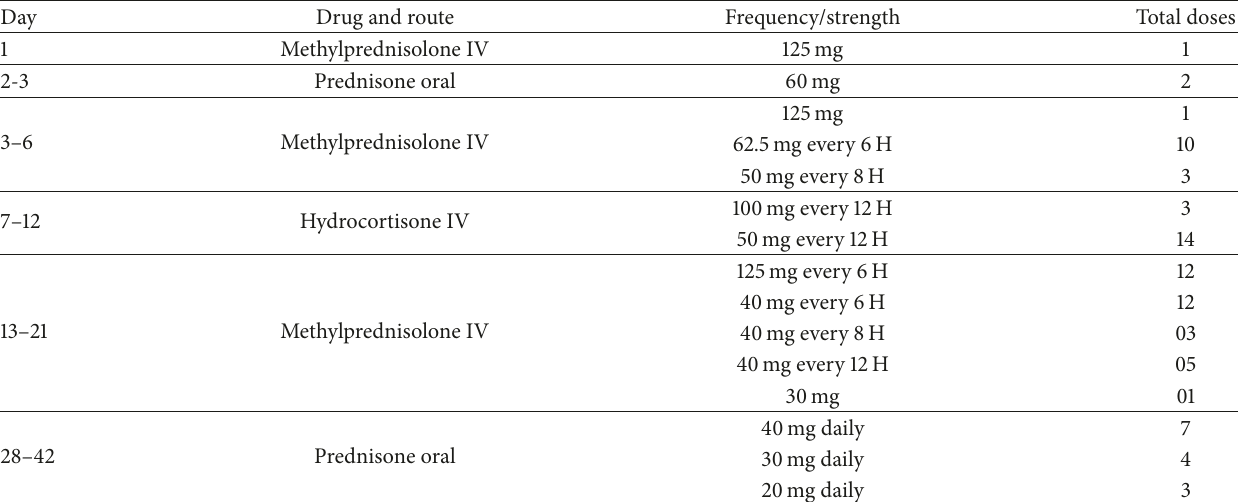
Table 2: Details of corticosteroids regimen (day since exposure to smoke, drug and route of administration, frequency and strength, and total number of doses).